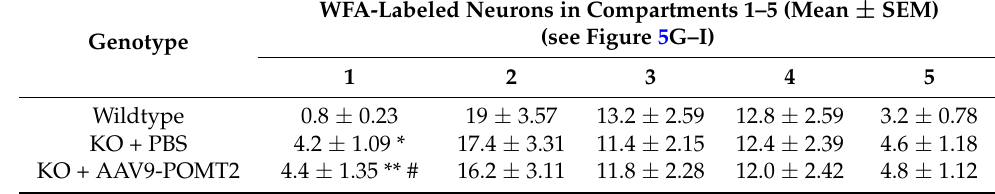
Figure 4. Histological abnormalities of the knockout mice were not rescued by postnatal AAV9-POMT2 treatment. Brains of AAV9-EGFP- and AAV9-POMT2-treated mice at three to five months of age were sectioned in the coronal plane and stained with cresyl violet. ( A – C ) Neocortex of AAV9-EGFP- and AAV9-POMT2-treated wildtype mice and knockout mice. Lamination defects were present in the knockout neocortex treated with either AAV9-EGFP or AAV9-POMT2. ( D – F ) Midline of two cerebral hemispheres of AAV9-EGFP- and AAV9-POMT2-treated wildtype mice and knockout mice. Two hemispheres were fused in the knockout neocortex treated with either AAV9-EGFP or AAV9-POMT2 (Asterisks in E and F). ( G – I ) Hippocampus of AAV9-EGFP- and AAV9-POMT2-treated wildtype mice and knockout mice. Lamination defects of neurons in CA1, CA3, and dentate gyrus was present in the knockout neocortex treated with either AAV9-EGFP or AAV9-POMT2. Asterisks in H and I indicate granule cell ectopia and # signs indicate lamination defects of CA1. Abbreviations: DG, dystroglycan; KO, knockout; WT, wildtype. Scale bar: 100 µ m for ( A – F ); 200 µ m for ( G – I ). Table 1. Abnormal distribution of wisteria floribunda lectin (WFA)-labeled neurons in the knockout neocortex is not rescued by postnatal gene